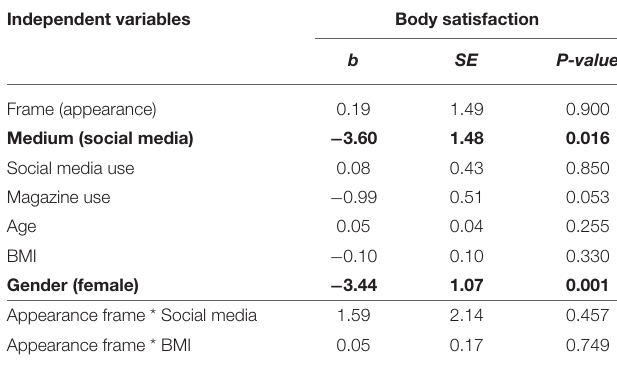
TABLE 1 | Moderated analysis explaining positive mood.